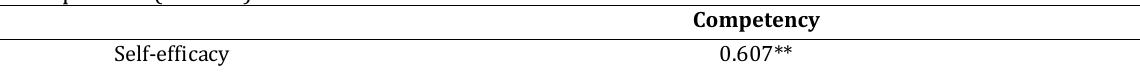
Table 5. Correlation (r) between self-efficacy and competency of nursing students in implementing EBP in clinical practice (n = 120)